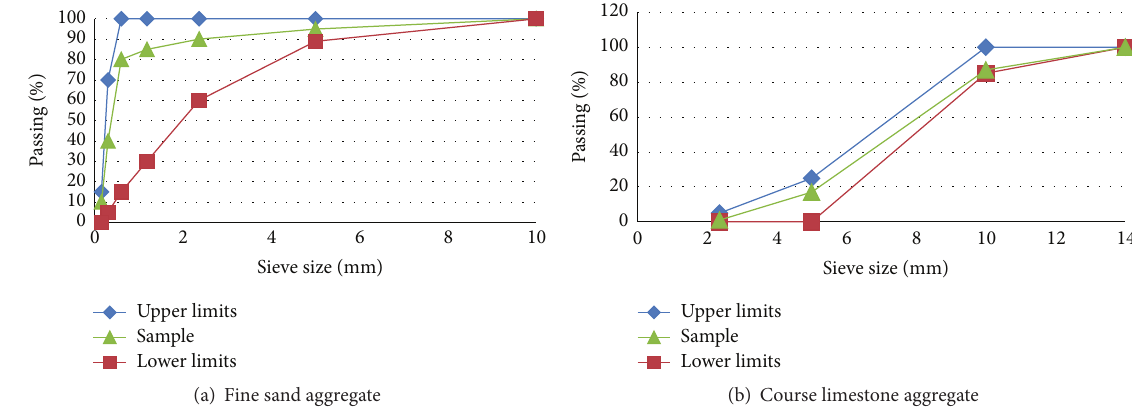
Figure 1: Particle size distribution.